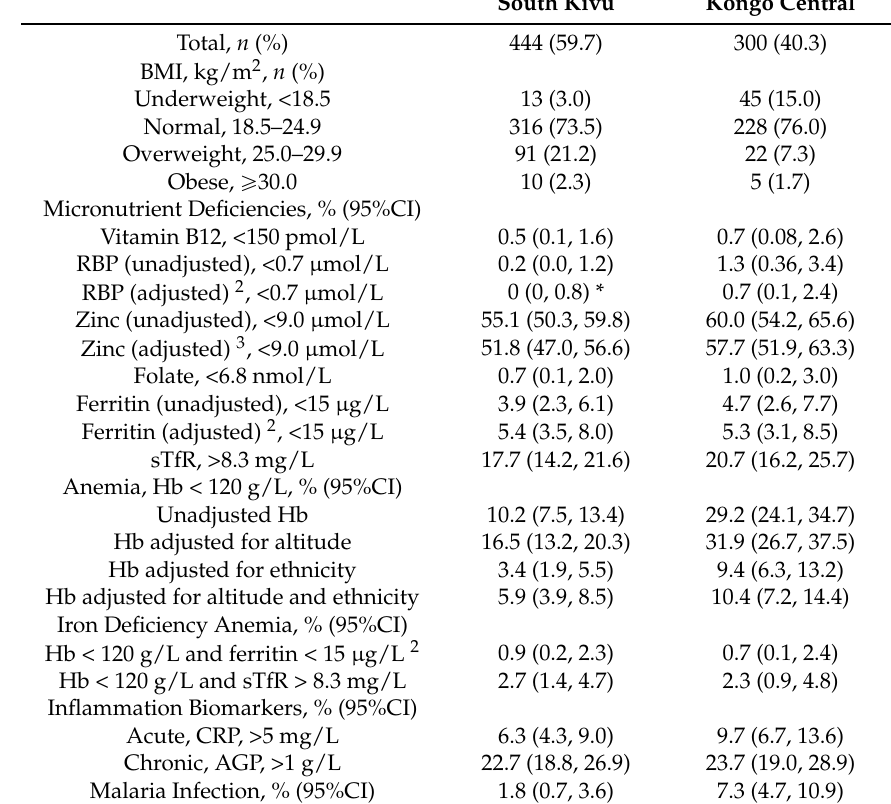
Table 4. Body mass index (BMI) and prevalence of micronutrient deficiencies, anemia, iron deficiency, inflammation and malaria among women of childbearing age ( n = 696–741 women) by province 1